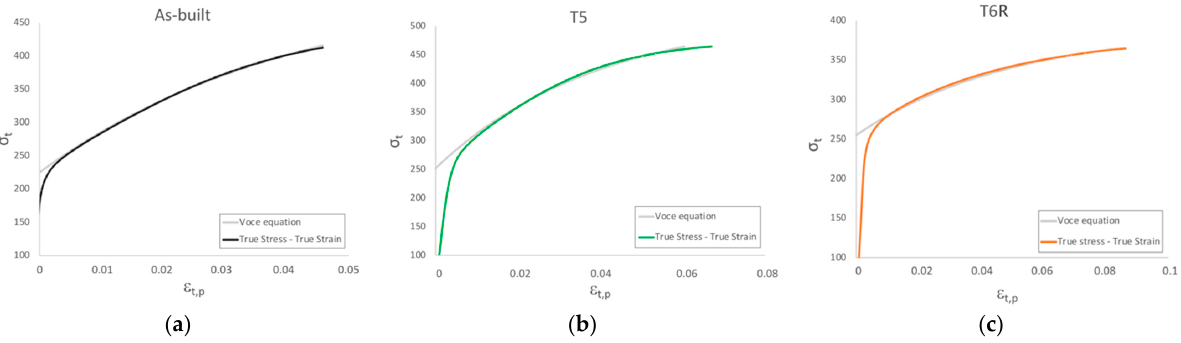
Figure 8. Comparison between true stress-true strain experimental curves and flow curves obtained with Voce equation of representative: ( a ) as-built, ( b ) T5, and ( c ) T6R tensile samples. Based on the Voce equation, the Kocks-Mecking model (Equation (2)) was developed Voce equation is expressed to describe the Stage III of work hardening, characterized by a linear behavior in a diagram representing the work hardening rate 𝜃 as a function of the true stress 𝜎 (cid:3047) , termed as Kock-Mecking (KM) diagram (Figure 9).